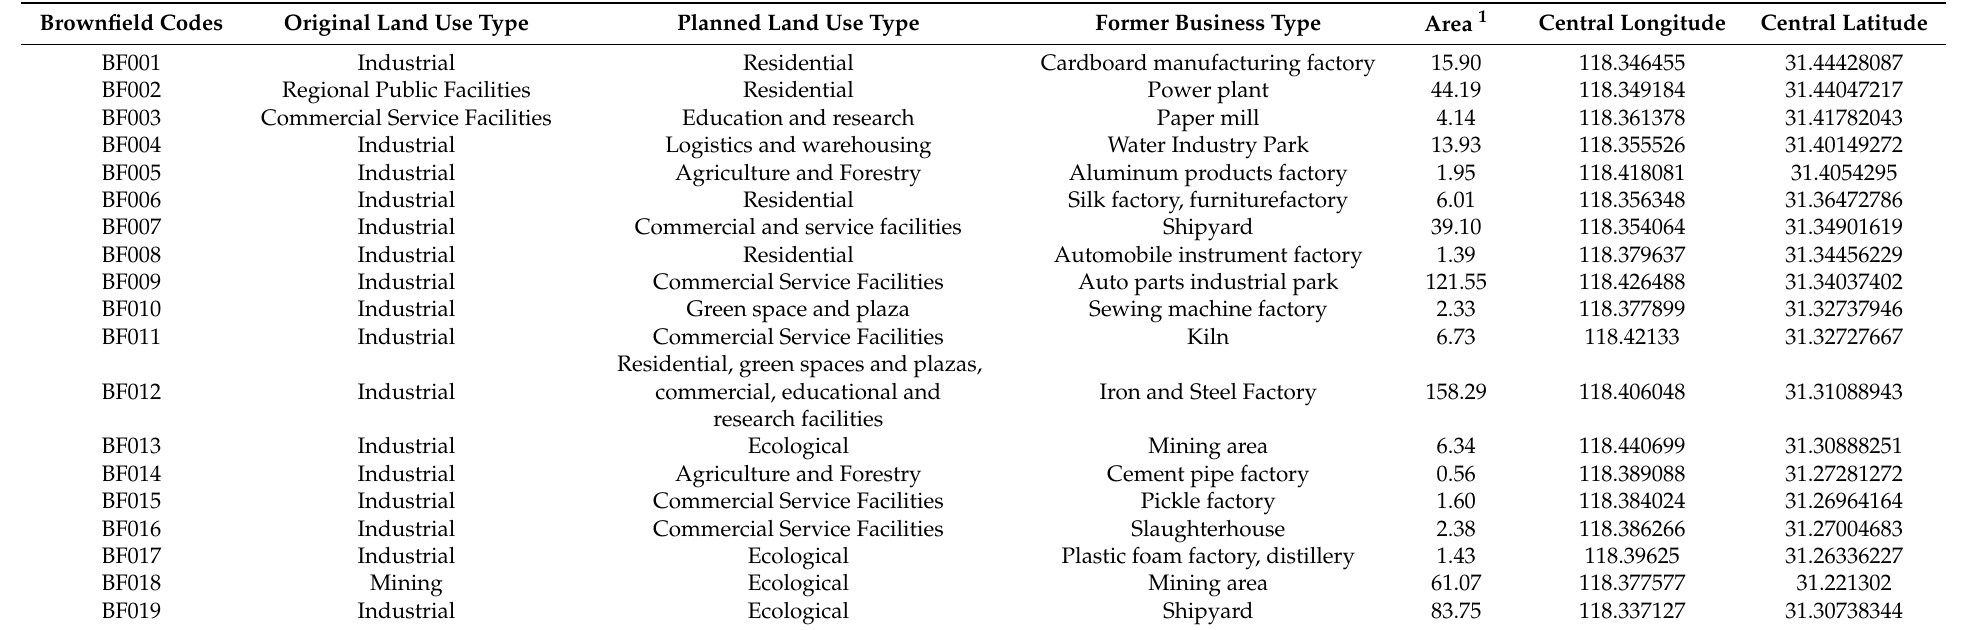
Table 3. List of brownfields in Wuhu